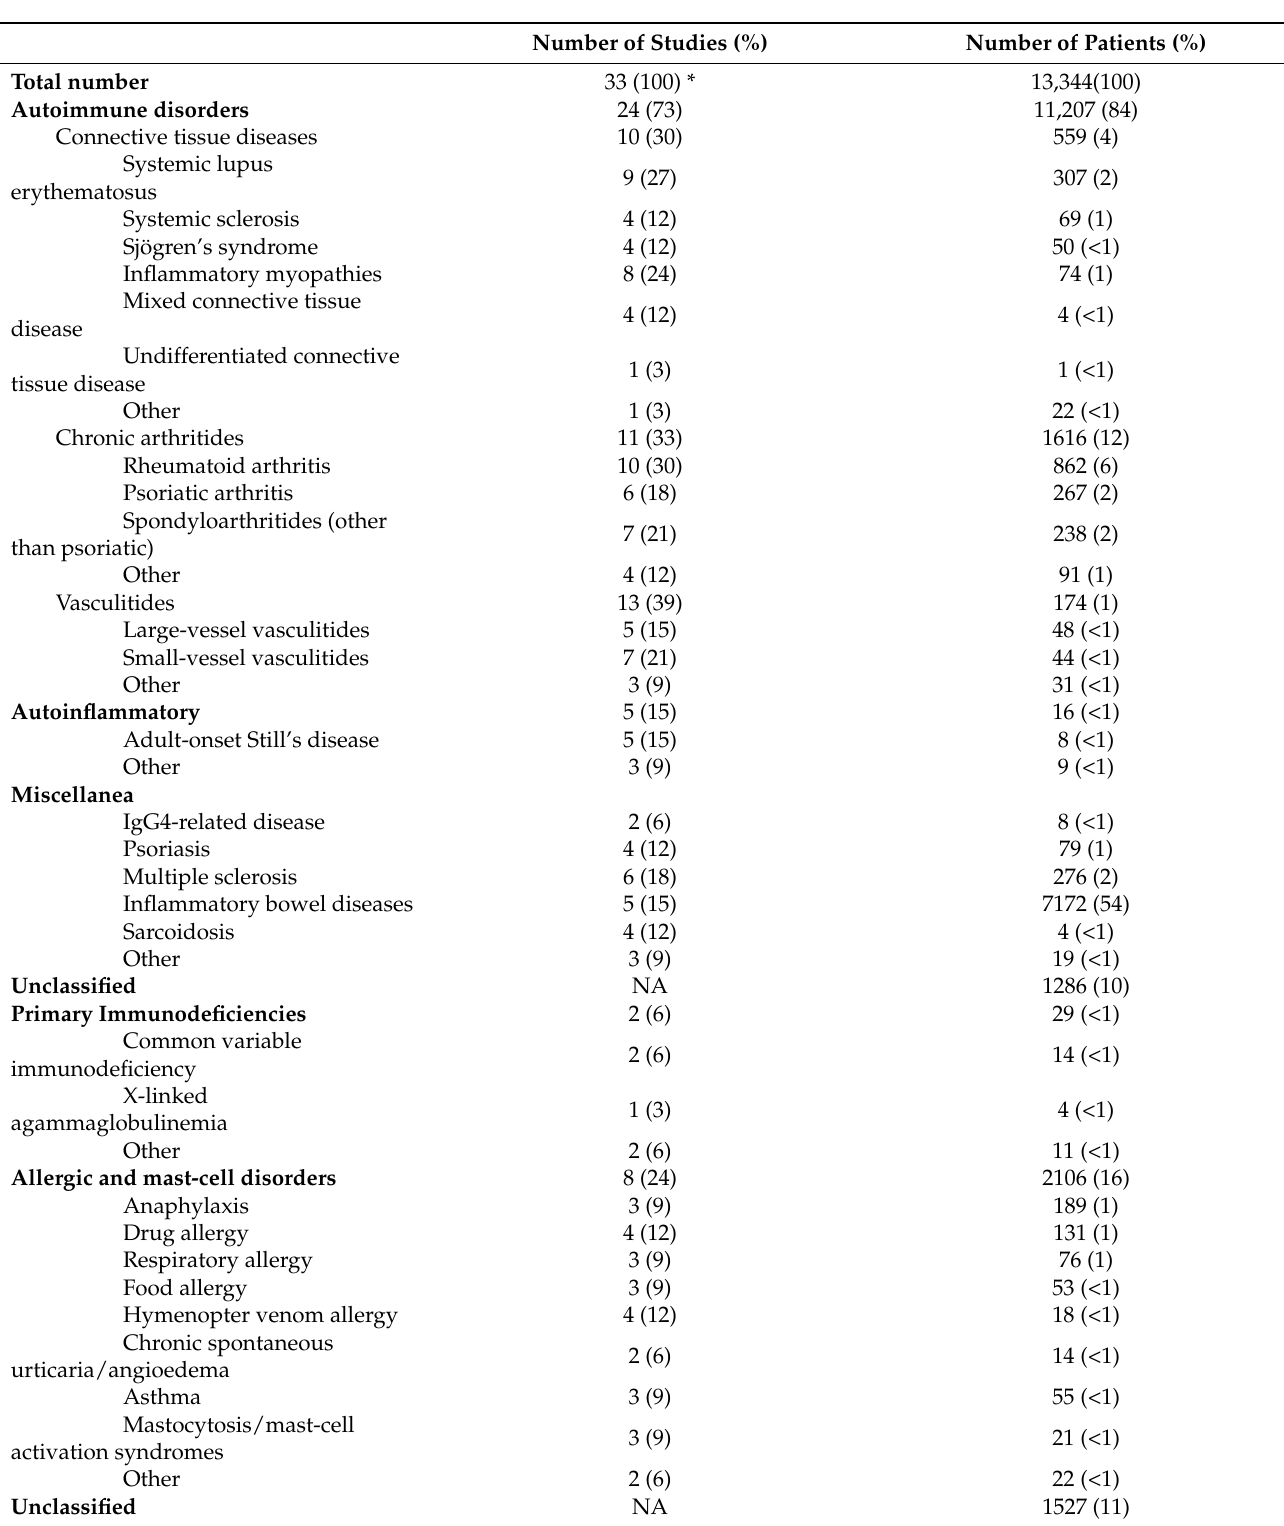
Table 2. Clinical features of patients with immune-mediated diseases vaccinated against SARS-CoV-2 among different